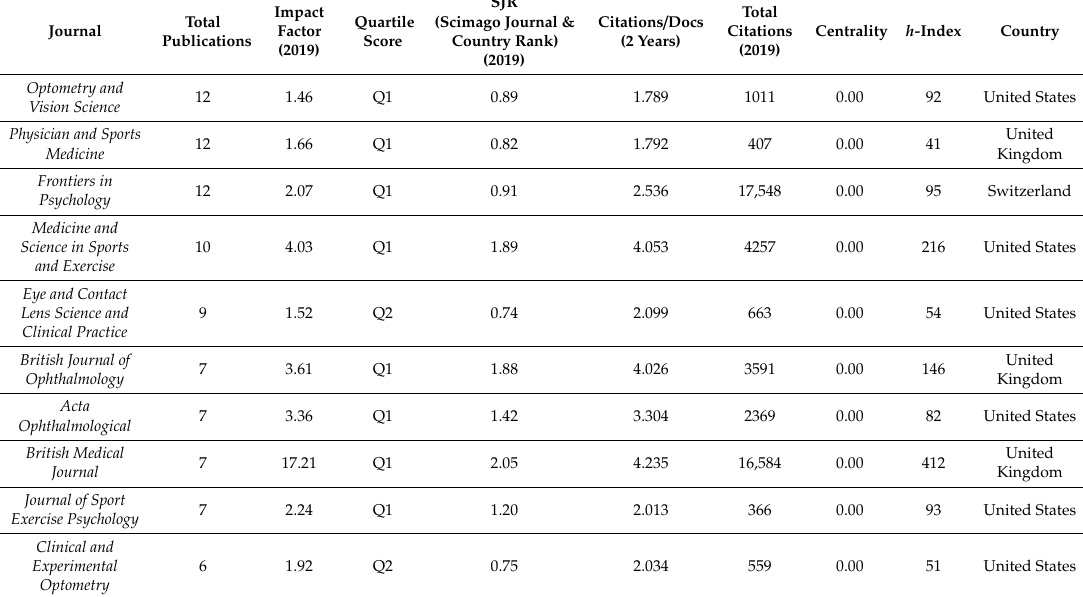
Table 3. Top 10 journals with the most publications.